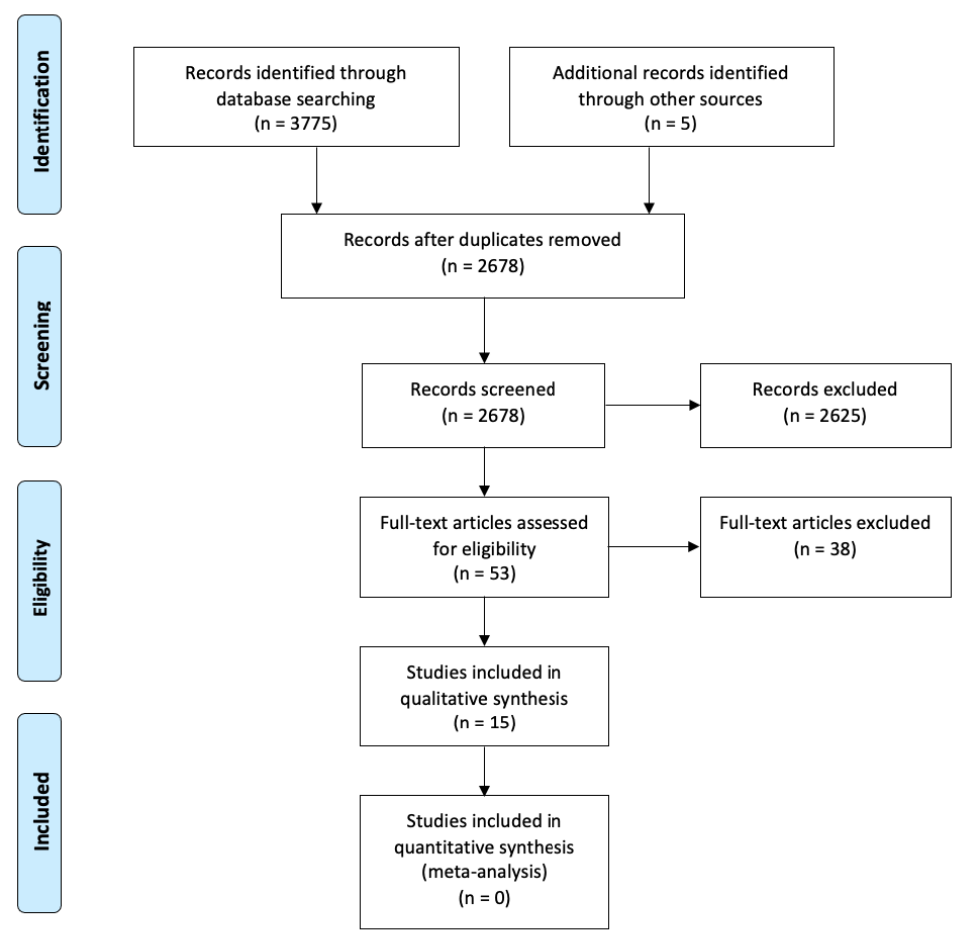
Figure 2. PRISMA flow diagram of study selection process.